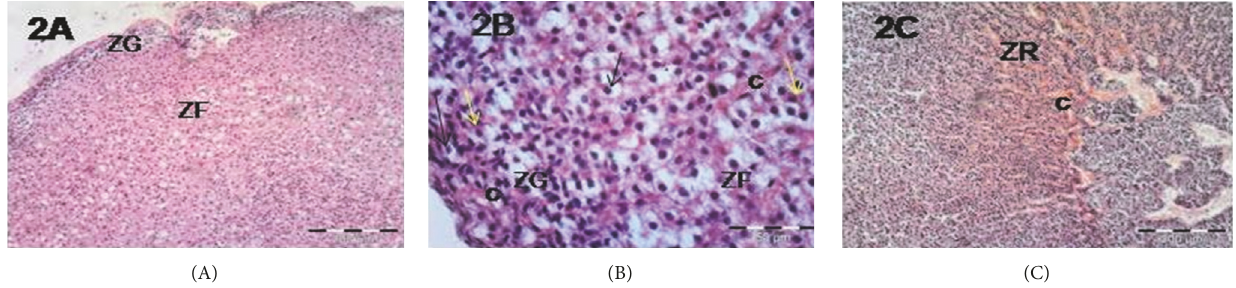
Figure 2: Photomicrographs of the adrenal gland of group II showing (A) loss of normal architecture of ZG and ZF, × 100; (B) higher magnification of ZG and ZF showing some cells with marked vacuolated cytoplasm (black arrow) and pyknotic nuclei; others are shrunken (yellow arrow) with pyknotic nuclei and deeply acidophilic cytoplasm; notice the congested blood capillaries (c), × 400; (C) ZR with markedly congested blood capillaries (c), × 100.